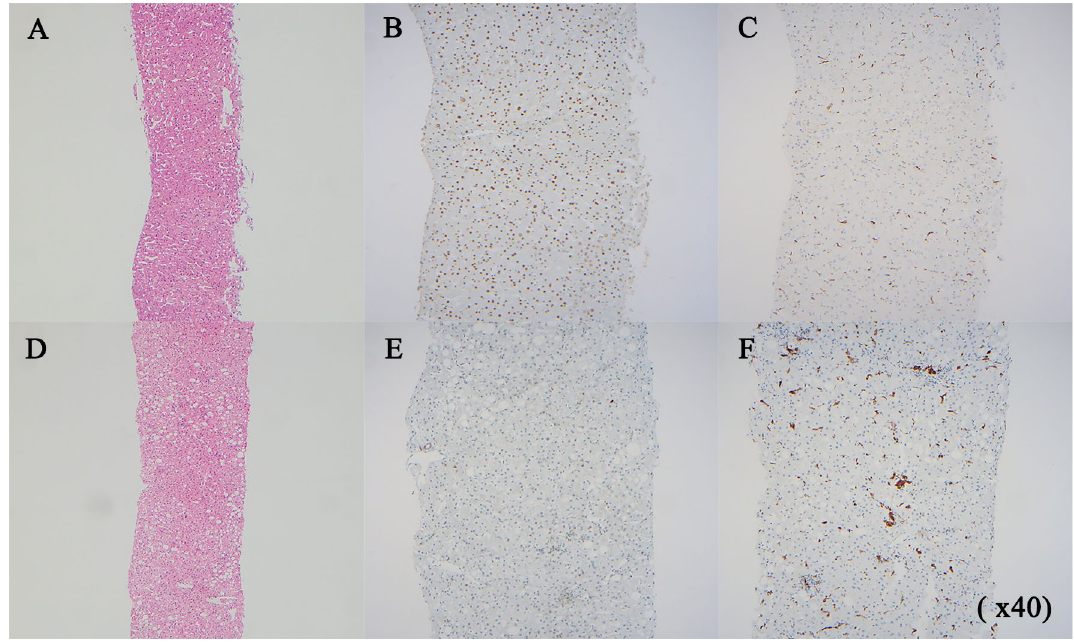
Figure 6. Representative photomicrograph and immunohistochemical results of NAFL and NASH patients. ( A – C ) NAFL patient with long telomere length [( A ) H&E stain, ( B ) PCNA, ( C ) CD68)], ( D – F ) NASH patients with short telomere length [( D ) H&E stain, ( E ) PCNA, ( F ) CD68)] [original magnification, ( A , D ), × 50; ( B , C , E , F ), × 100]; NAFL non-alcoholic fatty liver, NASH non-alcoholic